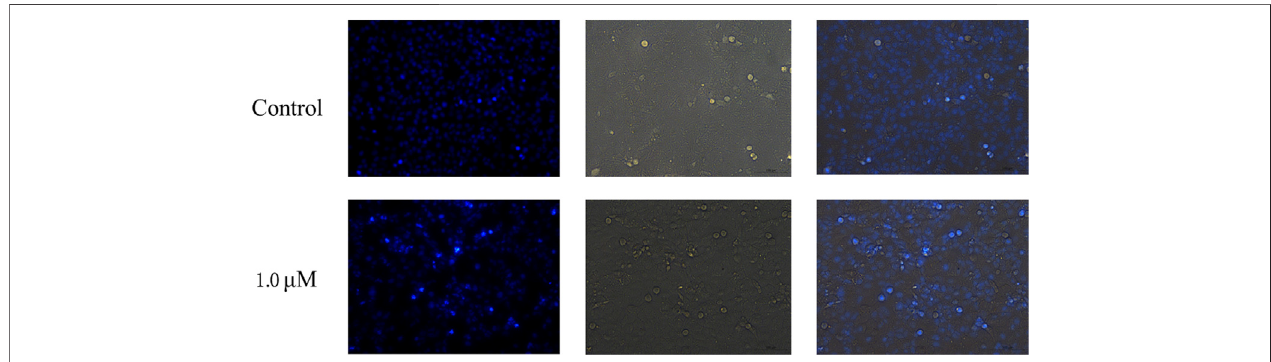
Frontiers in Chemistry |